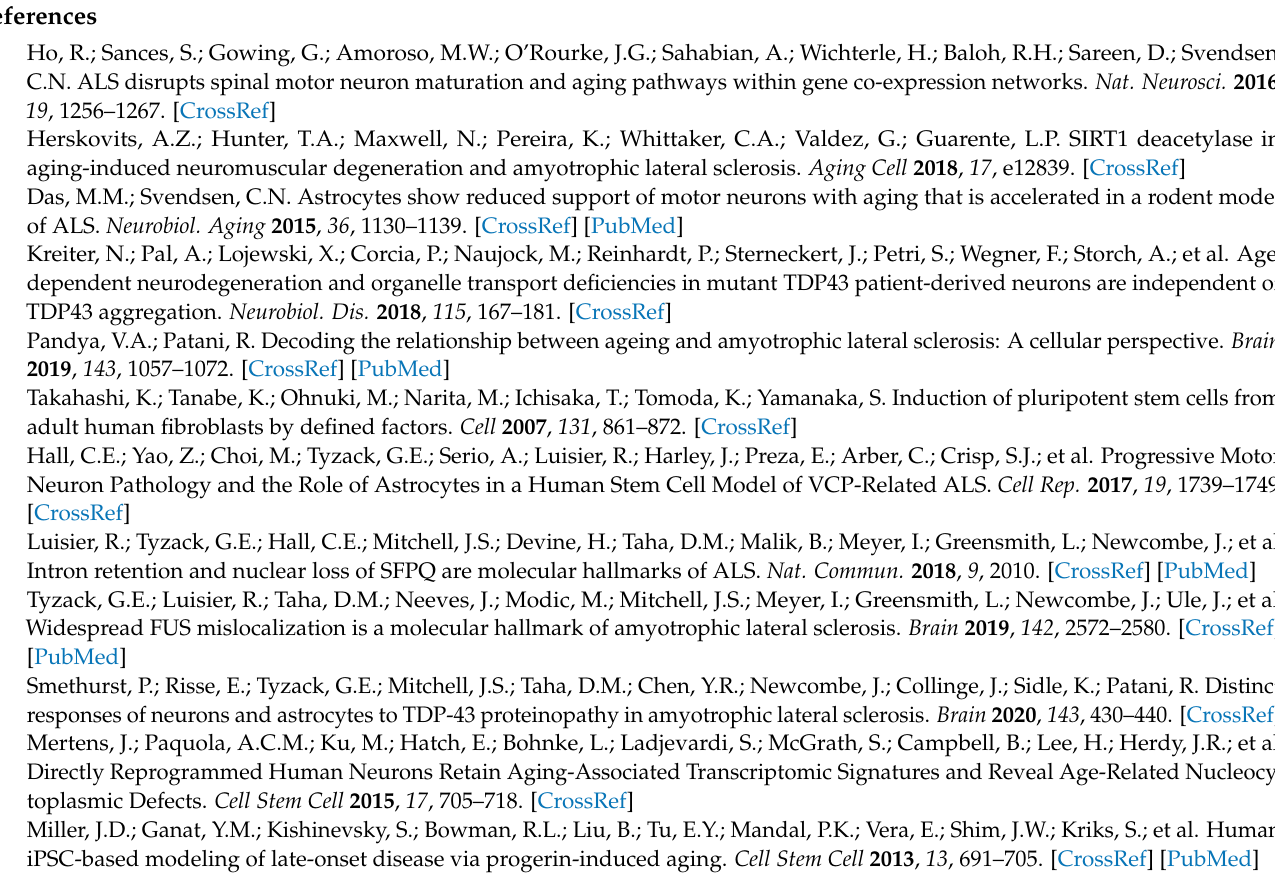
Supplementary Figure S3: 0.05 µ M BIBR1532 treatment has no effect on key developmental markers of iPSC-MN directed differentiation, Supplementary Tables: Table S1: N2-B27, Table S2: Antibodies used in this study, Table S3: qRT-PCR primer sequences, Supplementary Materials and methods: Western